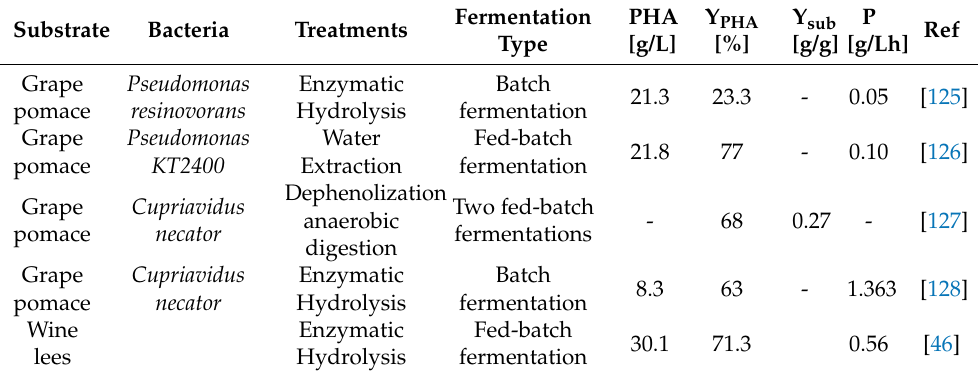
Table 5. Microbial synthesis of PHAs using different wine by-products as fermentative source.